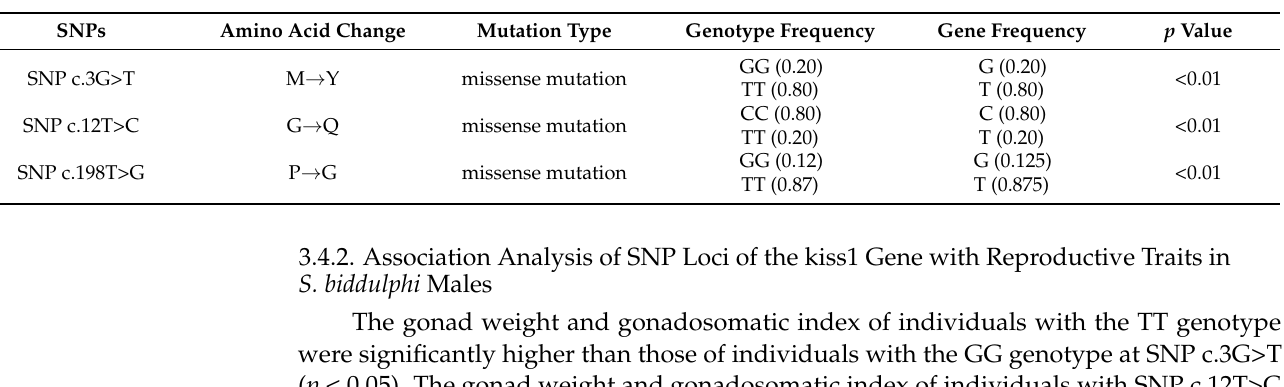
Table 3. SNP locus information of the kiss1 gene.